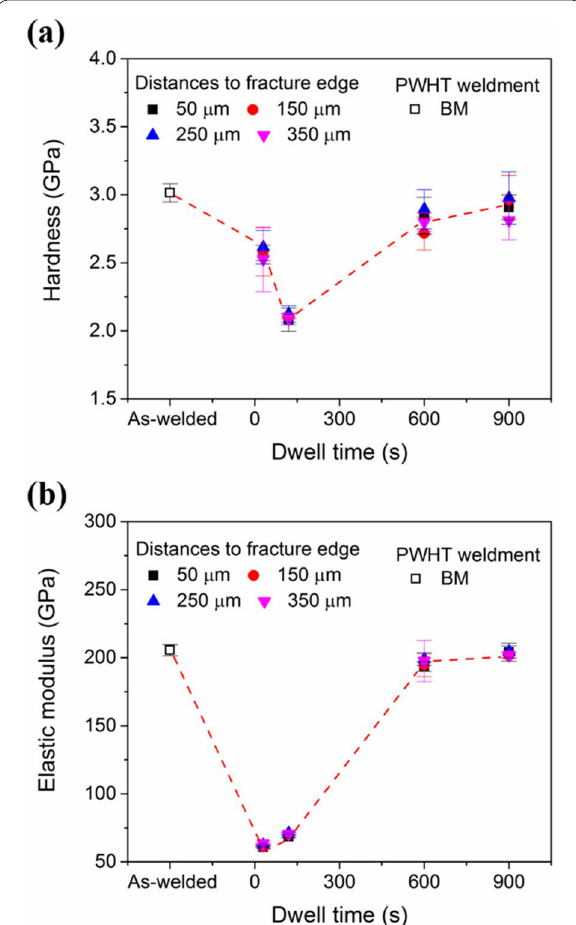
Figure 10 Comparison between ( a ) nanoindentation hardness, ( b ) elastic modulus as a function of dwell times, which are measured in different distance to fracture edges for CF specimens as well as PWHT